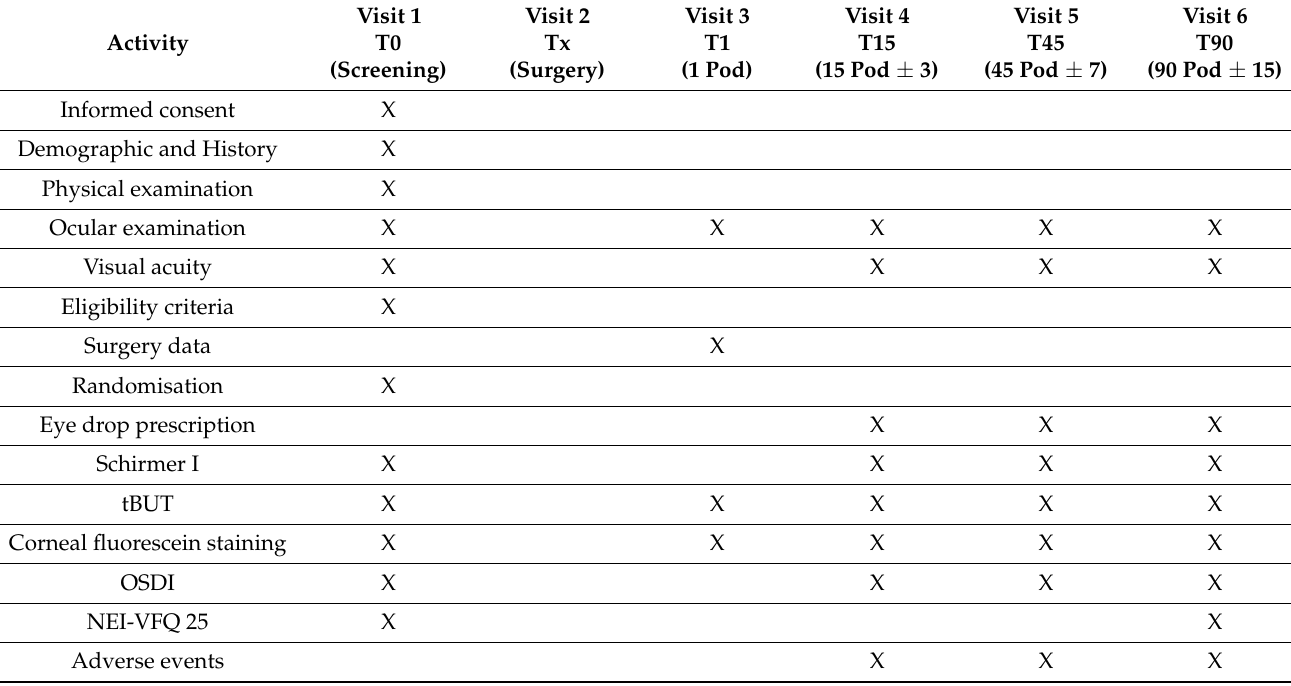
Table 1. Timetable of scheduled visits and examinations (pod: post-operative